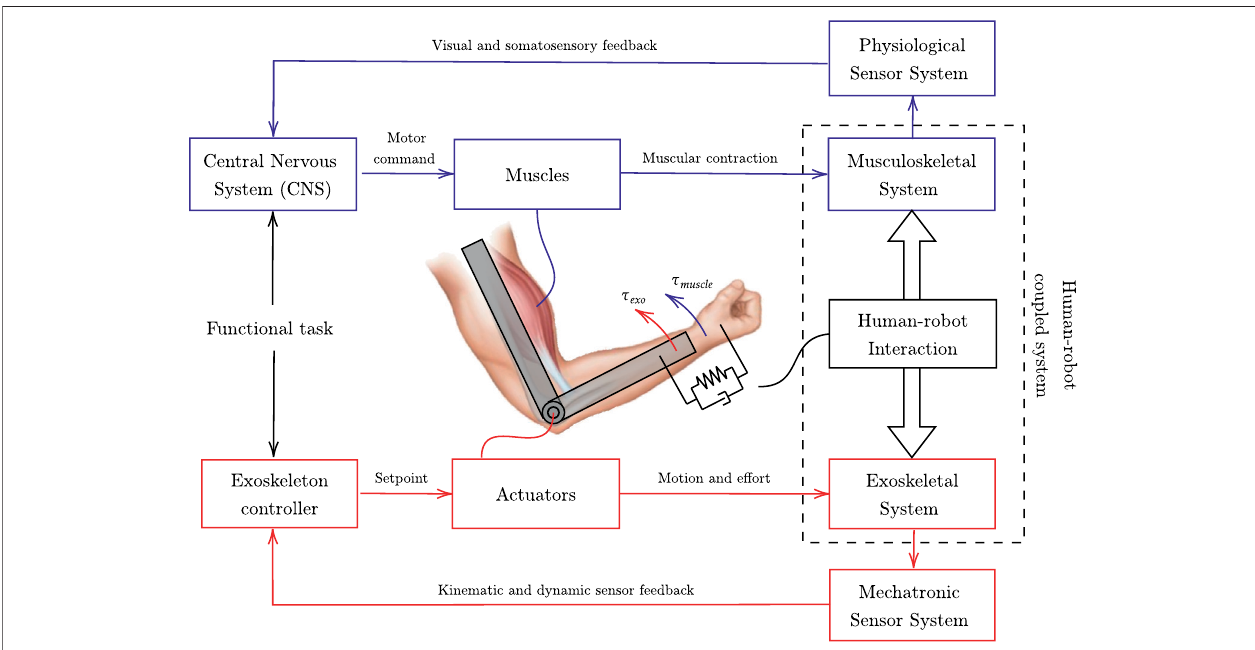
FIGURE1| Human-robotinteractionrepresentation.Theblueschemerepresentshumanmotorcontrol,andtheredschemereferstotheexoskeletoncontrol.The human-robot coupled system cooperates towards the completion of a shared functional task.